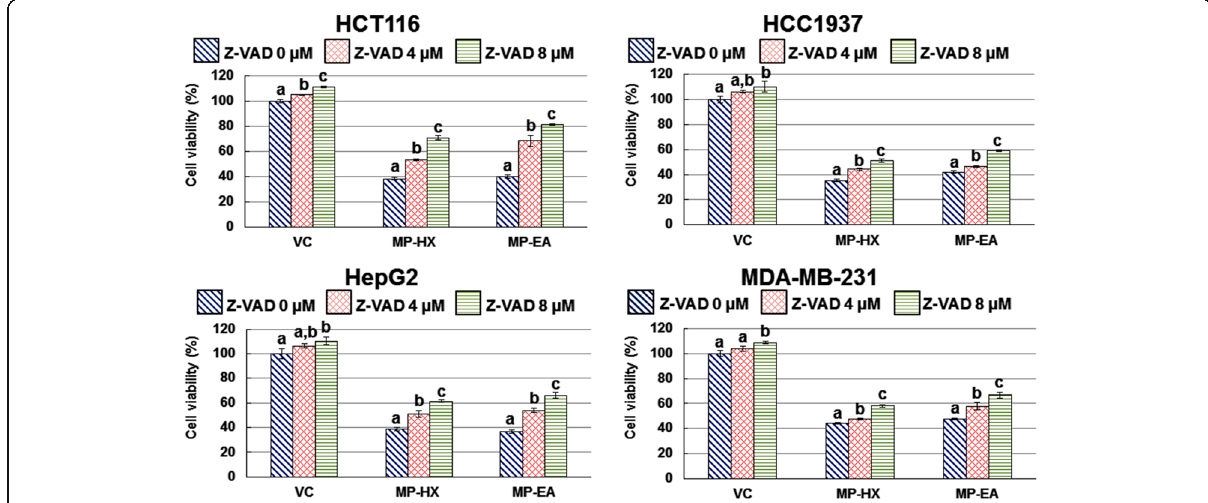
Fig. 8 Pan caspase inhibitor assay. MTS cell viability assay (48 h) was employed using MP-HX or MP-EA extracts on the cell lines indicated, in the presence or absence of Z-VAD-FMK inhibitor. The concentration of the extracts used in each treatment was at ~IC 50 value for the corresponding cell lines indicated. Values are mean ± SD ( n = 3). The values with different letters (a-c) are significantly different, p <